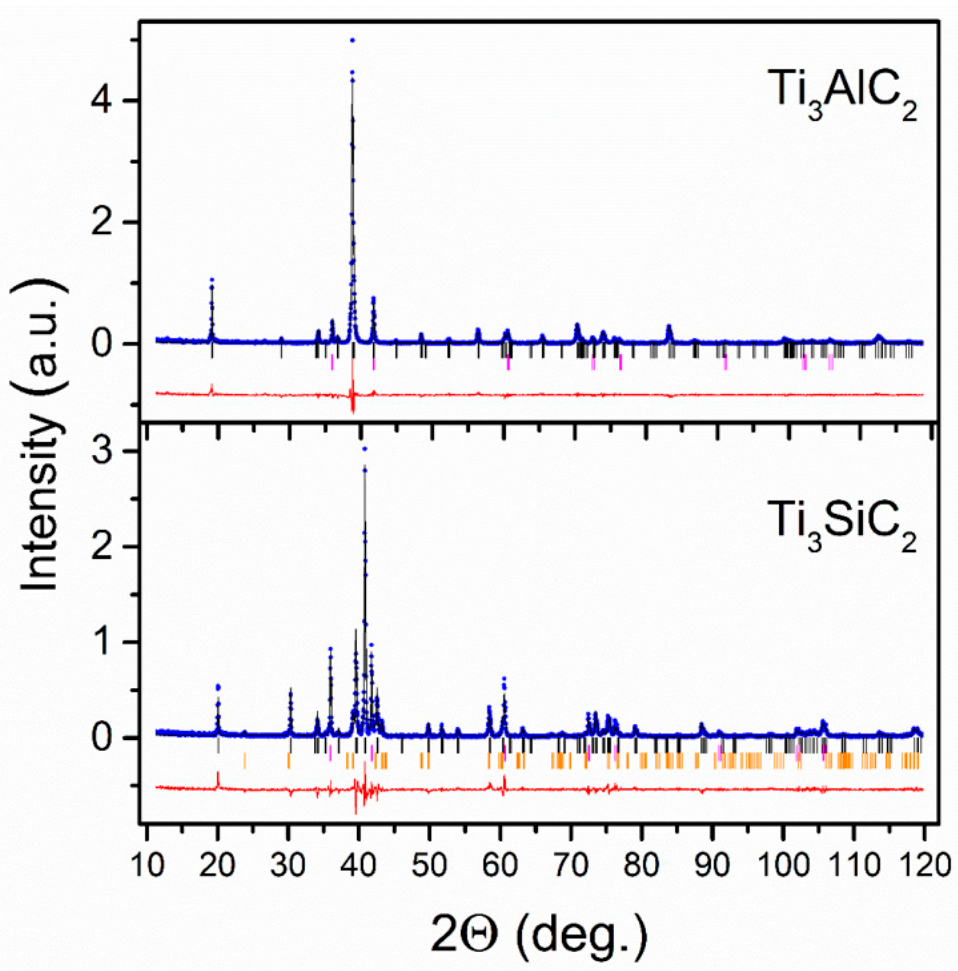
Figure 2. XRD patterns (blue dots) and the best-fit Rietveld refinement (solid black lines) of the Ti 3 AlC 2 and Ti 3 SiC 2 starting materials. The rows of vertical bars denote the Bragg peak positions for the corresponding MAX phase (black), TiC (magenta), and TiSi 2 (orange). The solid red line represents the difference between the experimental and calculated patterns.